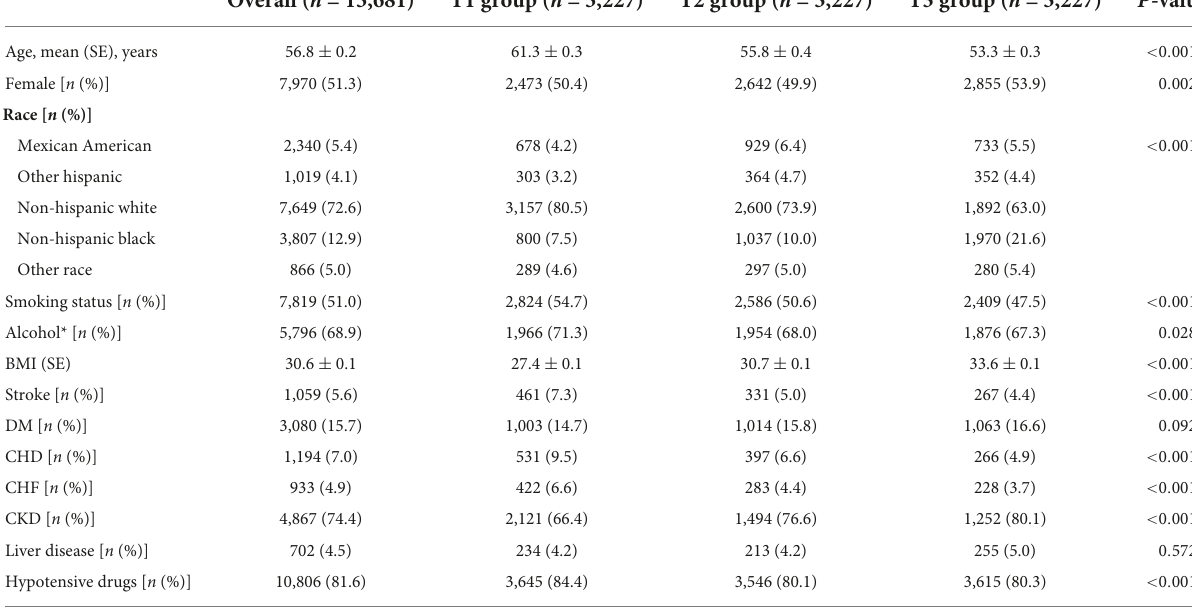
TABLE 1 Baseline study population characteristics (weighted).